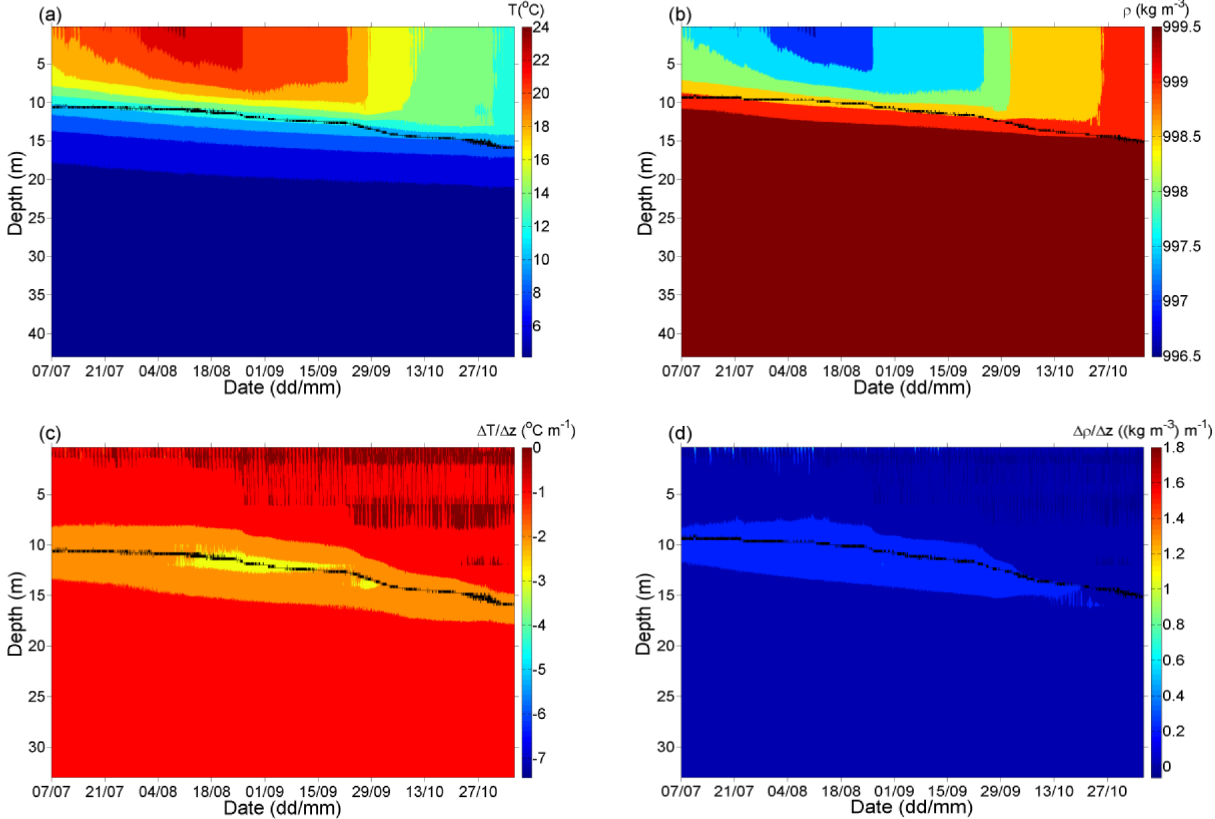
Figure 3. (a) Observed lake temperatures during the period from 7 July to 5 November 2018, and (b) the corresponding water densities calculated from Eq. (5). Panels (c) and (d) depict the vertical gradients of water temperature and density. The black lines in panels (a) and (c) show the thermocline depth, whereas those shown in panels (b) and (d) depict the pycnocline depth. Both the thermocline and pycnocline depths are determined as described in Sect. 3.1. The temporal resolution of all data is